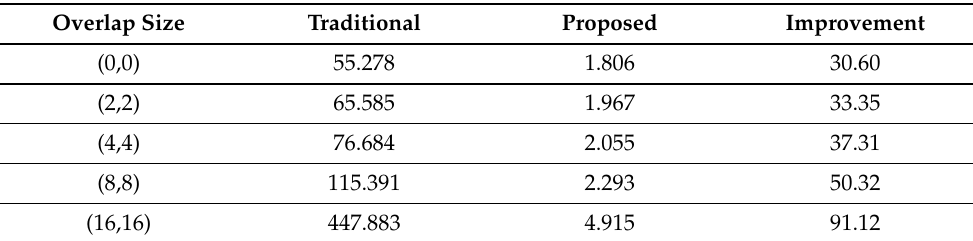
Table 6. FEI time (milliseconds) of different methods.